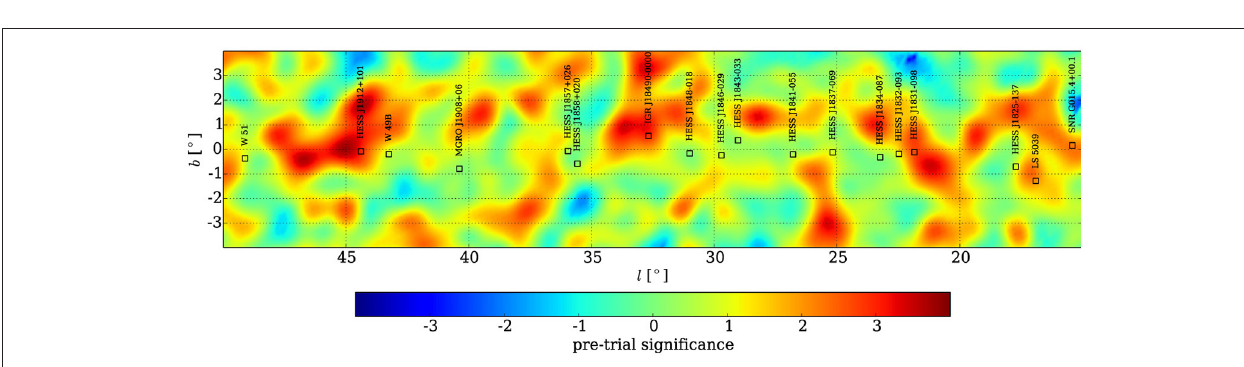
FIGURE 4 | Residual significance